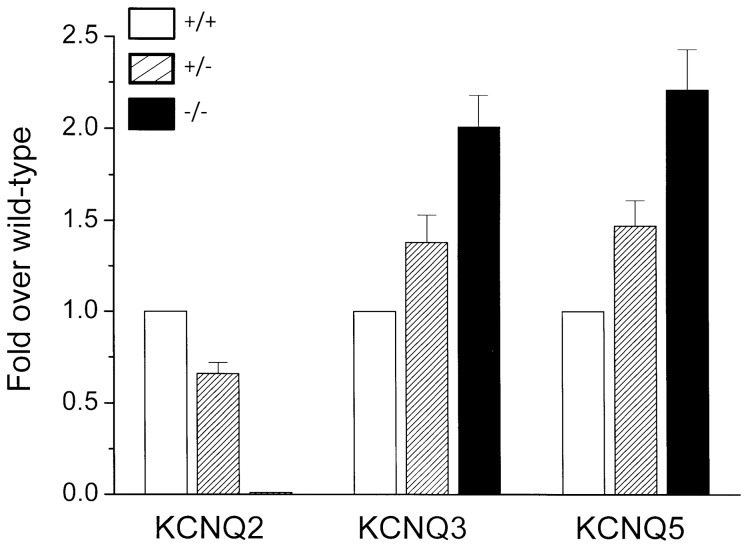
Quantitative PCR of relative mRNA levels in sympathetic ganglia.Levels in embryonic wild-type (+/+), heterozygote (+/−) and homozygote (−/−)KCNQ2 gene-truncated mice. Bars show means ± SEM of 6 experiments, using 3 qPCR replicates for each.